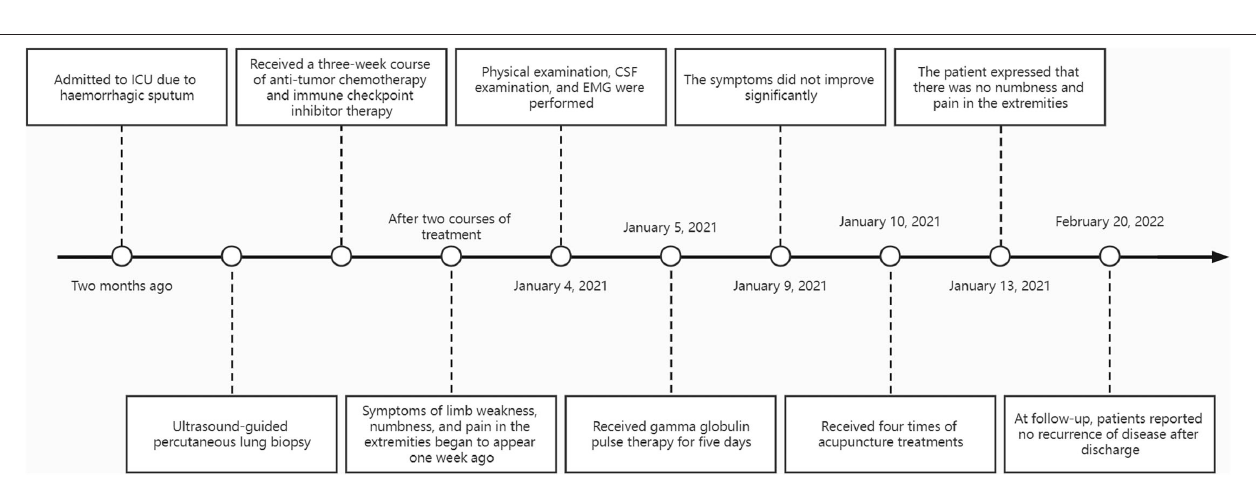
FIGURE 2 | Timeline with relevant data from the episode of